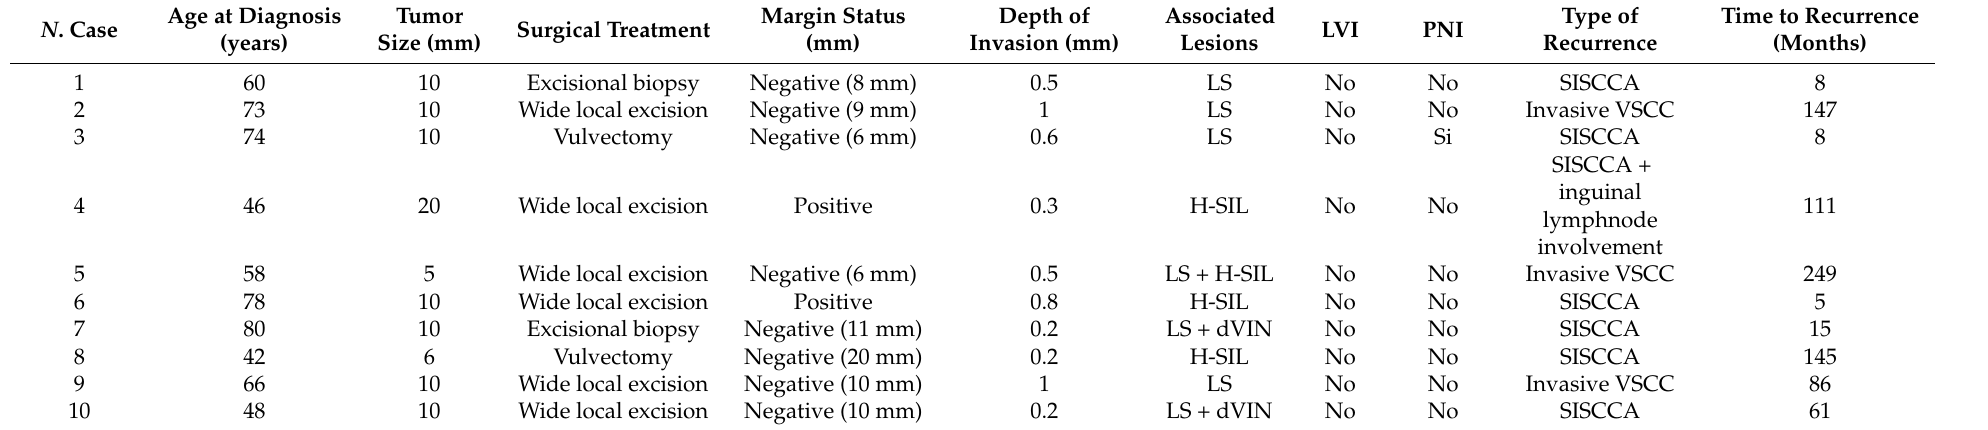
Table 2. Characteristics of patients with recurrent SISCCA or invasive vulvar